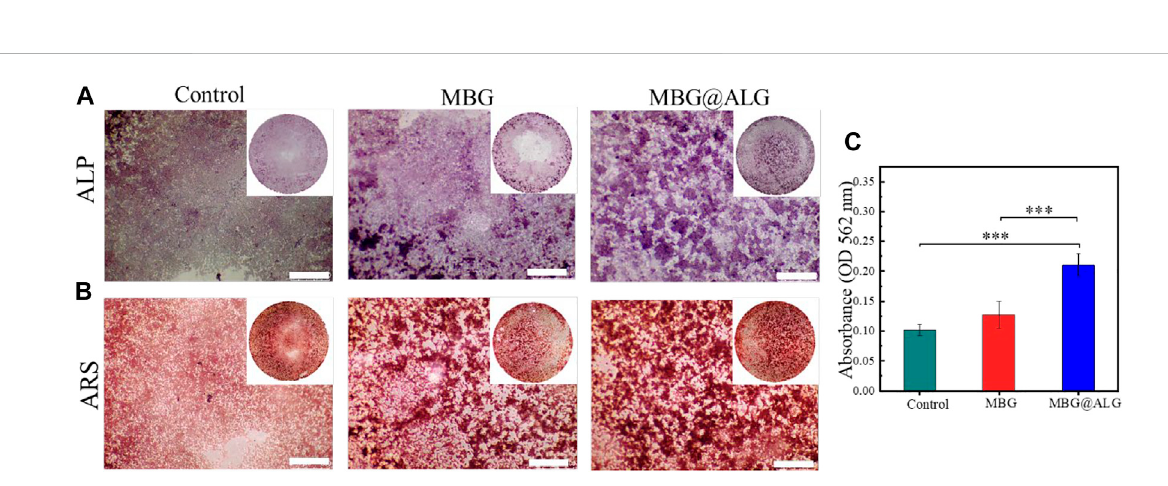
FIGURE 8 (A) ALP staining after MC3T3-E1 cell was cocultured with MBG and MBG@ALG for 7 days. (B) ARS staining after MC3T3-E1 cell was cocultured with MBG and MBG@ALG for 14 days. (C) ARS staining quanti fi cation after 14 days. (Bar = 500 μ m, *** p <